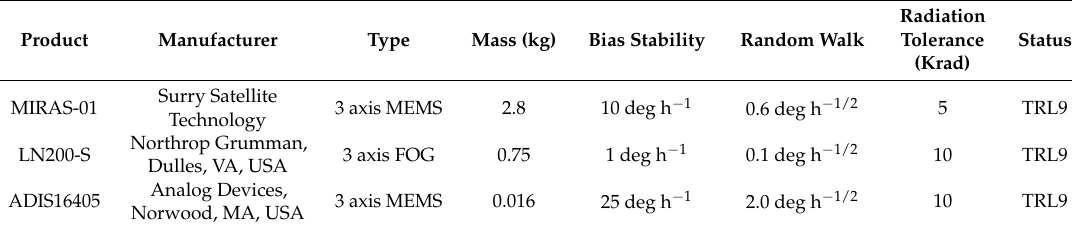
Table 21. Gyroscope Performance Data [23].